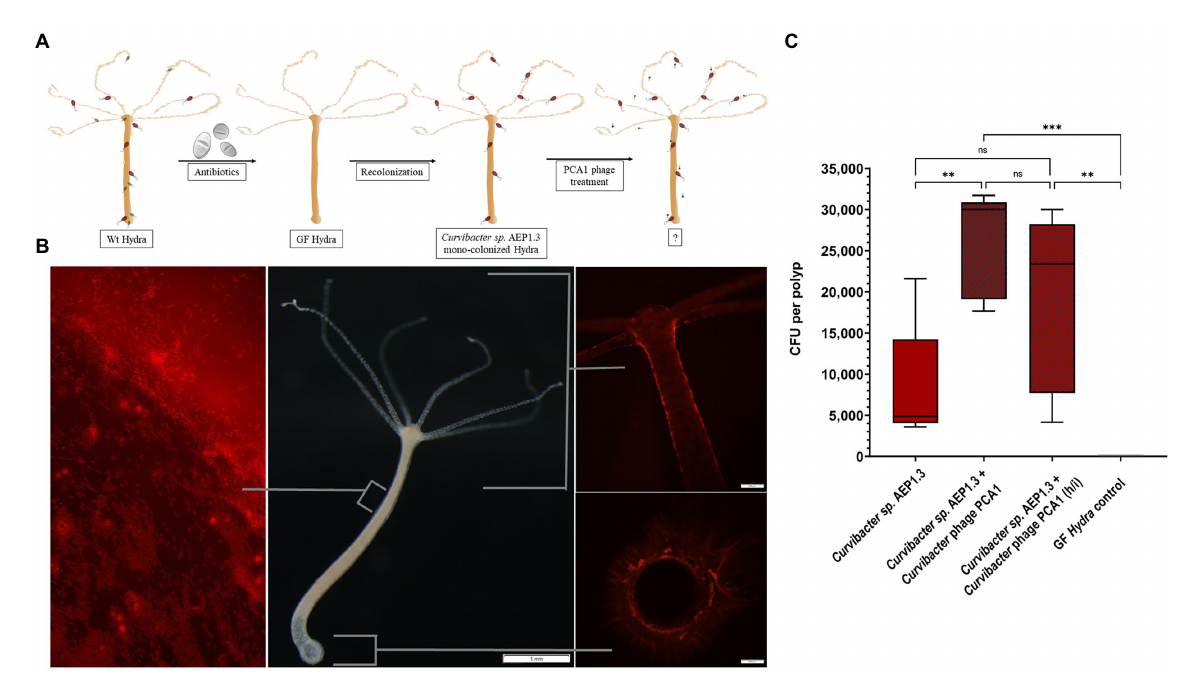
FIGURE 4 (A) Schematic showing experimental setup, starting with antibiotic treatment of wild-type Hydra vulgaris AEP . Resulting germ-free Hydra vulgaris AEP were recolonized with Curvibacter sp. AEP1.3. The mono-colonized Hydra were then exposed to Curvibacter phage PCA1. (B) Hydra vulgaris AEP mono- colonized with fluorescently labeled Curvibacter sp. AEP1.3. The left image shows a section of the body column and mucus layer under fluorescent light, the middle image shows a Hydra vulgaris AEP polyp under white light. The image to the right shows the head and foot region under fluorescent light. (C) Colony-forming unit counts of Curvibacter sp. AEP1.3 mono-colonized polyps with and without Curvibacter phage PCA1 and a germ-free control ( n = 5). Heat-inactivated phages are indicated by “h/i.” ** indicates adjusted p <0.0077, ns indicates non-significant data, *** indicates p =